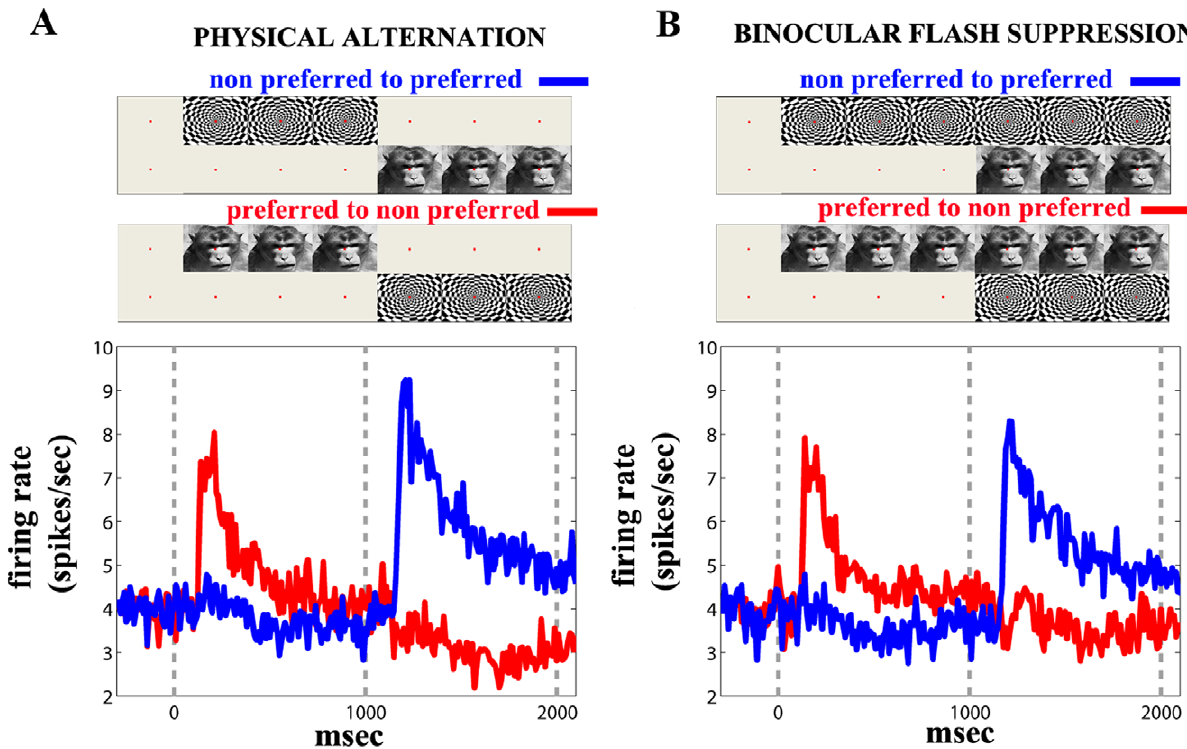
Figure 1. Mean population response in the LPFC during physical alternation and BFS (adapted and modified from [ 7 ] ). (A) Mean population activity averaged across units showing significant sensory modulation during monocular physical alternation between disparate stimuli. Blue trace shows the mean activity when visual stimulation starts from a non-preferred stimulus followed by switching to a preferred visual pattern. Red curve depicts the mean activity when visual stimulation starts with a preferred pattern followed by switching to a non-preferred stimulus in the contralateral eye. (B) Same a (A) for BFS. Perceptual dominance of a preferred stimulus (blue, t =1001–2000 msec) results in increased spiking activity similar to that observed during physical alternation of the same stimuli. When the same stimulus is perceptually suppressed (red, t =1001–2000) the mean population activity remains suppressed until the end of the trial.